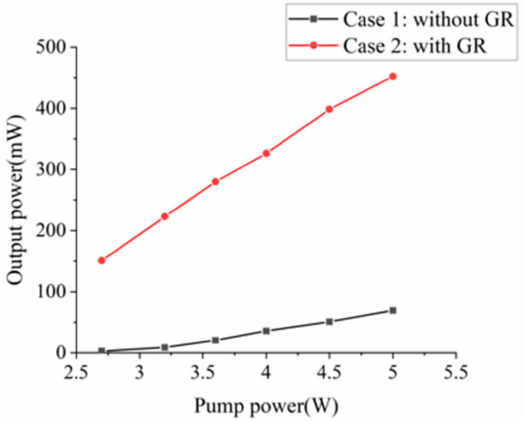
Figure 3. Output power in the two cases. Pump power is measured from the pigtail fiber of the laser